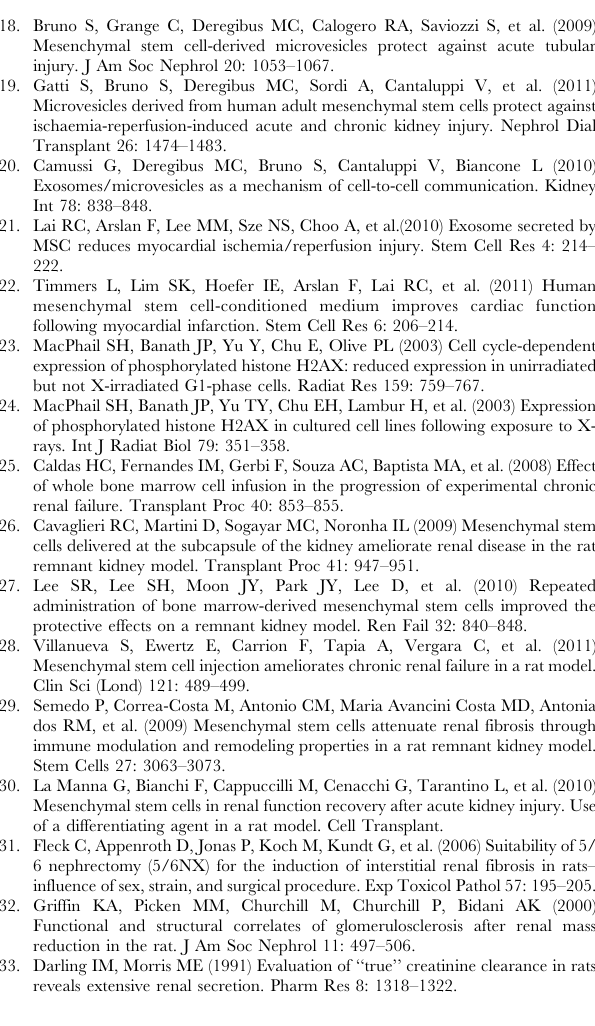
Table S1 Terminal kidney function measurements in the exosome and PBS groups. There were no significant differences. Table S2 Longitudinal measurements after exosome treatment at week 6 after SNX. Week numbers indicate the week after SNX. Week 5 represents the week before treatment. There were no significant